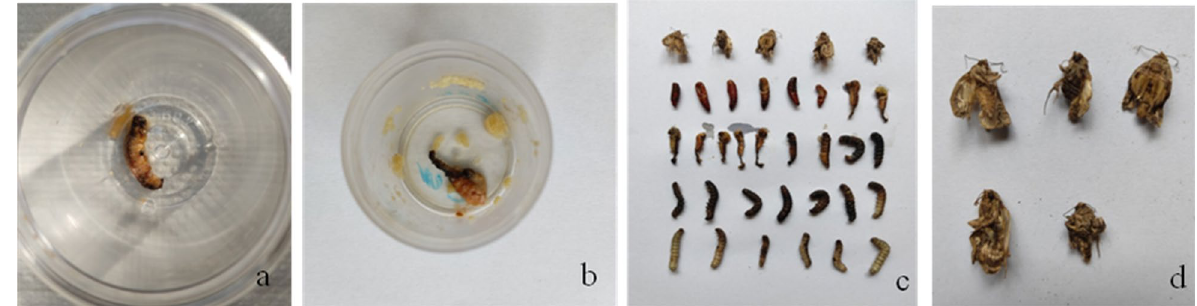
Fig. 1 a Liquification from 5th instar larva of Spodoptera frugiperda . b Molting defects in SpfrNPV infected S. frugiperda larva. c Mortality observed in 4th and 5th instar S. frugiperda larvae, pre-pupae, pupa due to SpfrNPV infection. d Deformation in wings, antennae and abdomen of adult moths of S. frugiperda due to SpfrNPV